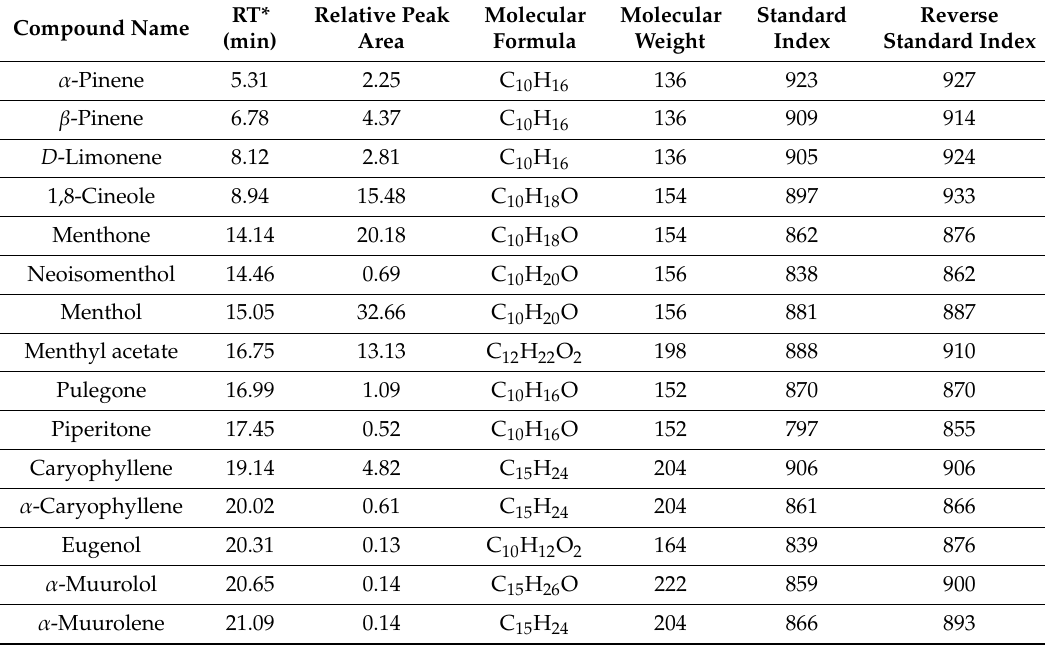
Table 2. Chemical composition of the oil from Mentha piperita